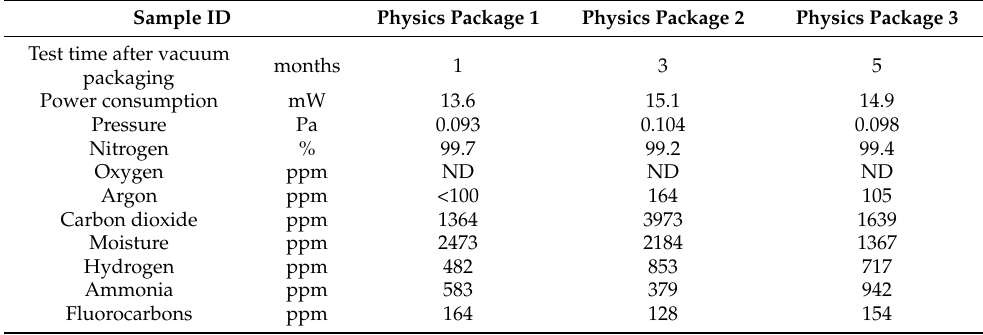
Table 2. Residual gas analysis results of 3 different physics packages after vacuum packaging tested at different time. Sample ID Physics Package